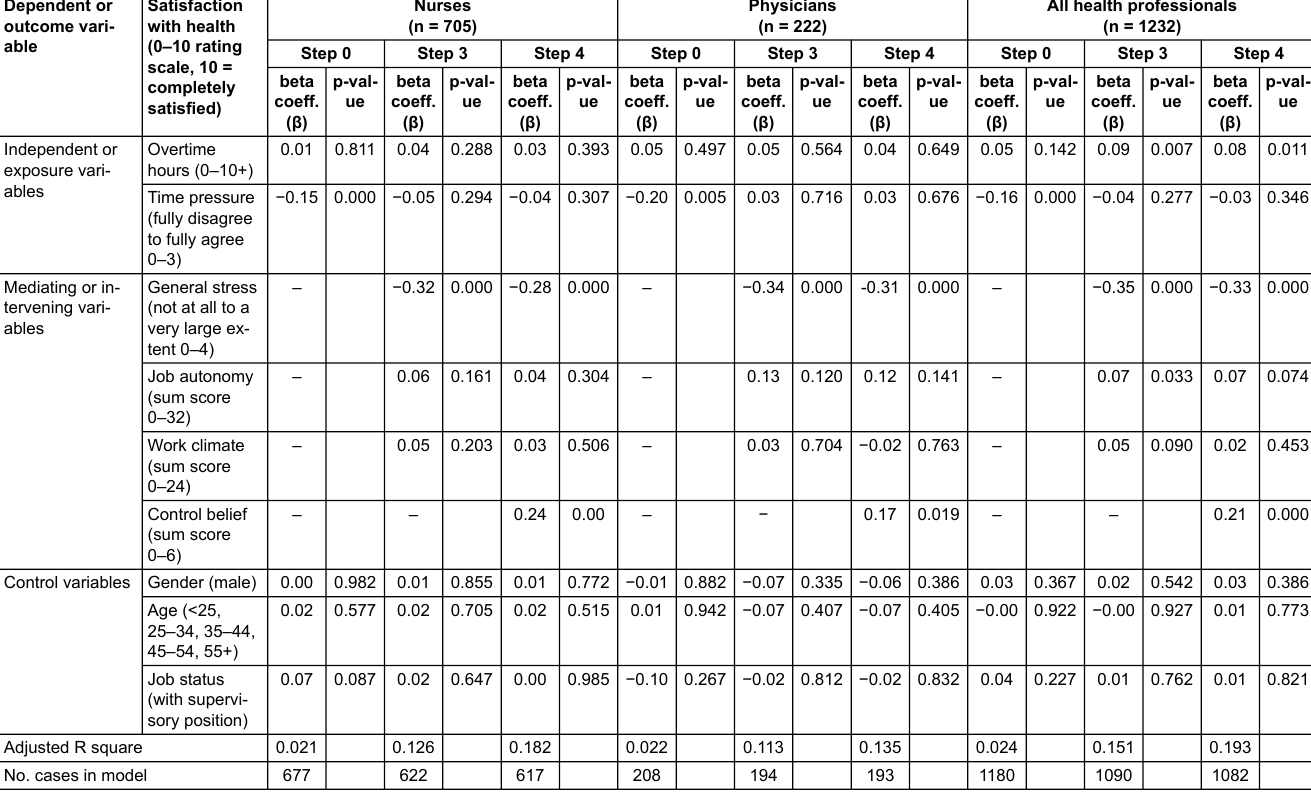
Table 4c: Explaining satisfaction with life among health professionals – results of a stepwise multiple linear regression analysis (step 0, step 3 and 4). Dependent or Satisfaction outcome vari- with able